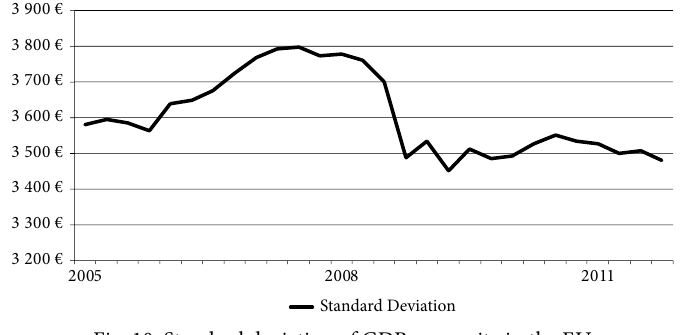
Fig. 10. Standard deviation of GDP per capita in the EU (2005 to 2011 with all countries except for Romania and Bulgaria) Source : own